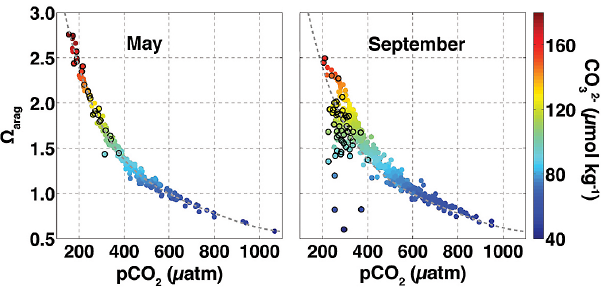
Fig. 5. May (left) and September (right) (cid:127) arag as a function of p CO 2 (µatm) and CO 2 − (µmolkg − 1 ). The dashed gray line is a 3 5th order polynomial fit to the May data. Surface data ( < 9m) are highlighted in each panel using bold concentra- 3